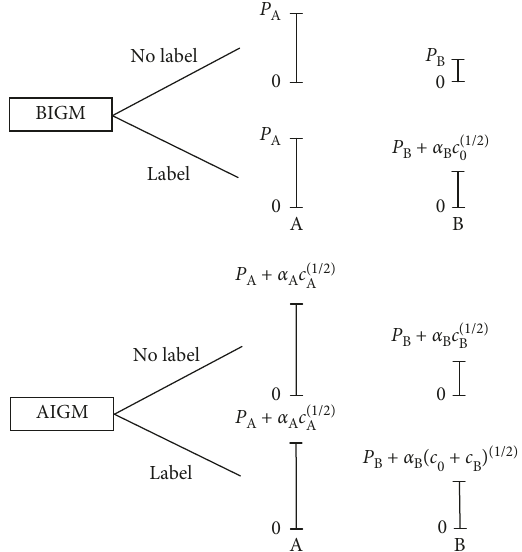
Figure 4: Prices of manufacturers’ products in BIGM and